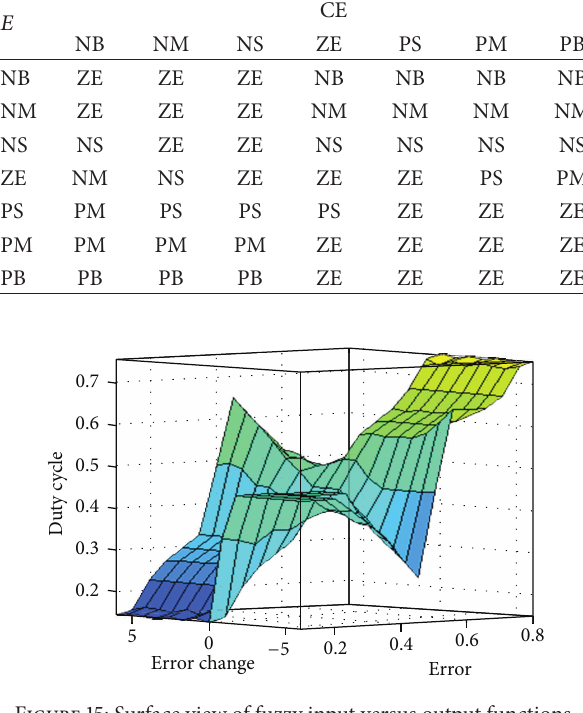
to the error ( 𝐸 ) and change of error (CE) is observed clearly.